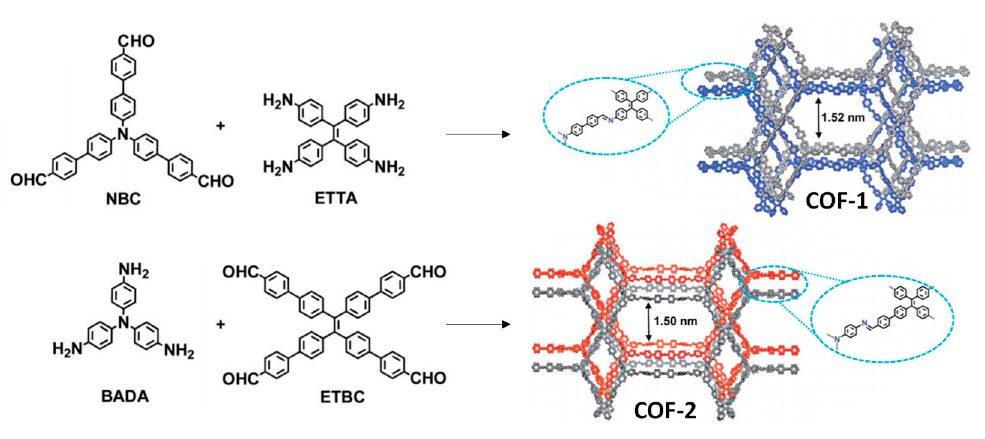
Figure 17. Synthesis of interpenetrated COF-1 and COF-2 as photoredox catalytic materials for dehalogenation reactions. Adapted from Reference [67], Published by the Royal Society of Chemistry. Table 15. Dehalogenation reactions mediated by COFs.